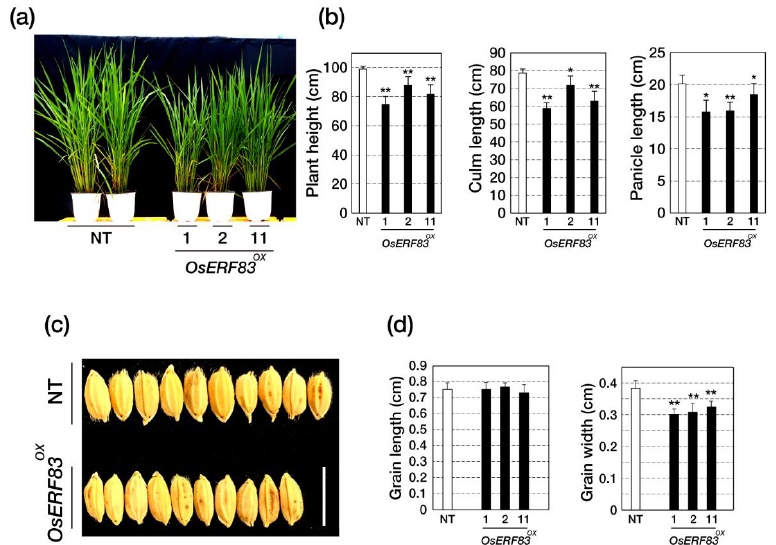
Figure 3. Morphological analysis of OsERF83 OX transgenic plants. ( a ) The whole plant height of 2-month-old OsERF83 OX and NT plants grown in paddy fields. ( b ) The plant height was measured after the heading stage of the rice. A total of 18 plants for each line were measured. Data represent the mean value ± SD ( n = 10). ( c , d ) The grain size of OsERF83 OX line and NT plants. A total of 25 grains from each line were measured. Bar = 1 cm. Two asterisks (**) indicate statistically significant differences at p < 0.01, and one asterisk (*) indicates significant differences at p < 0.05 compared with NT based on the Student’s t -test. Data are shown as the mean ± SD ( n = 25).